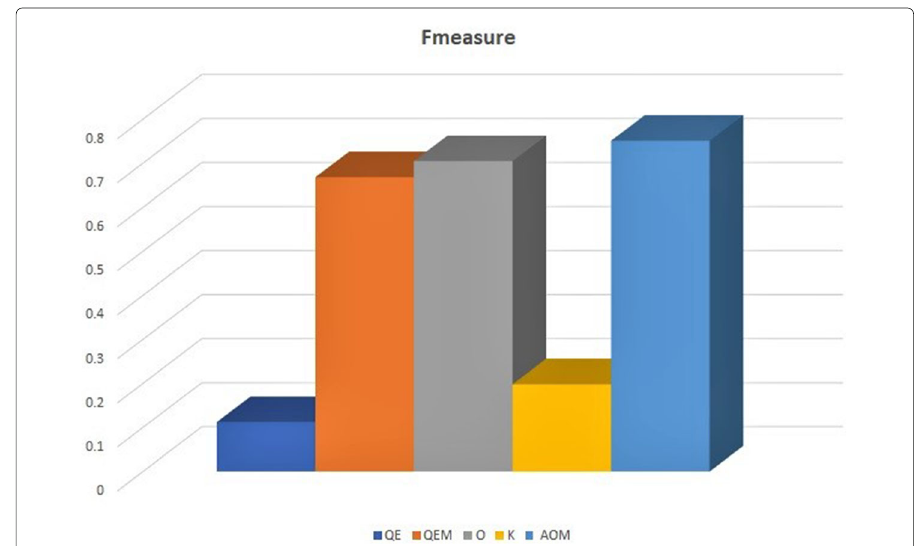
Fig. 12 This figure represents the average of the F-measure for quantum entropy, modified quantum entropy (proposed), Otsu, Kapur method, and the hybrid of the proposed and Otsu,